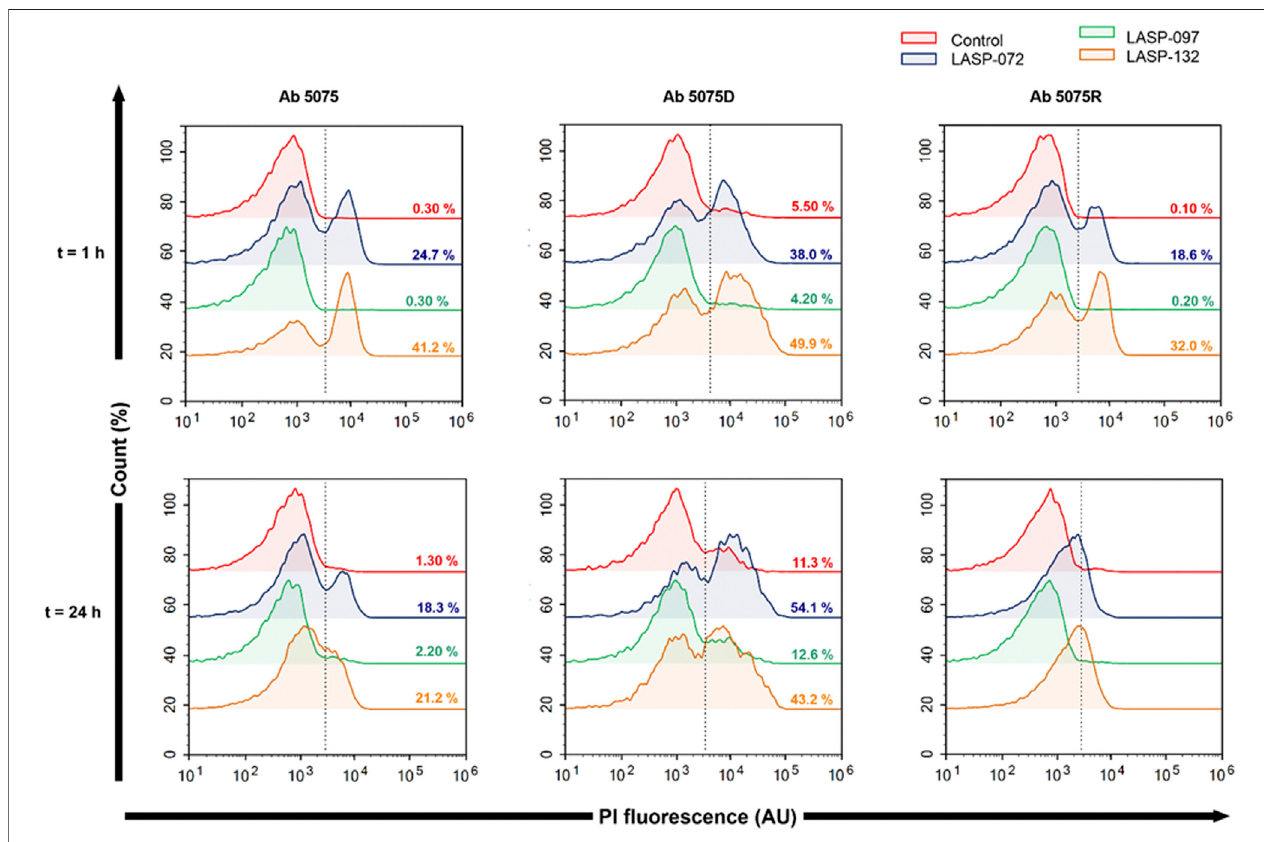
FIGURE 5 | Bacterial fl ow cytometry analysis. Early log phase of A. baumannii 5075, 5075D and 5075R were treated with LASP-072, LASP-097 and LASP-132 (0.04 mM, 1 and 24 h). Bacterial cells were stained with PI and analyzed by fl uorescence-activated cell sorting (FACS) fl ow cytometry. The histograms represent the percentage of PI-positive cells after each